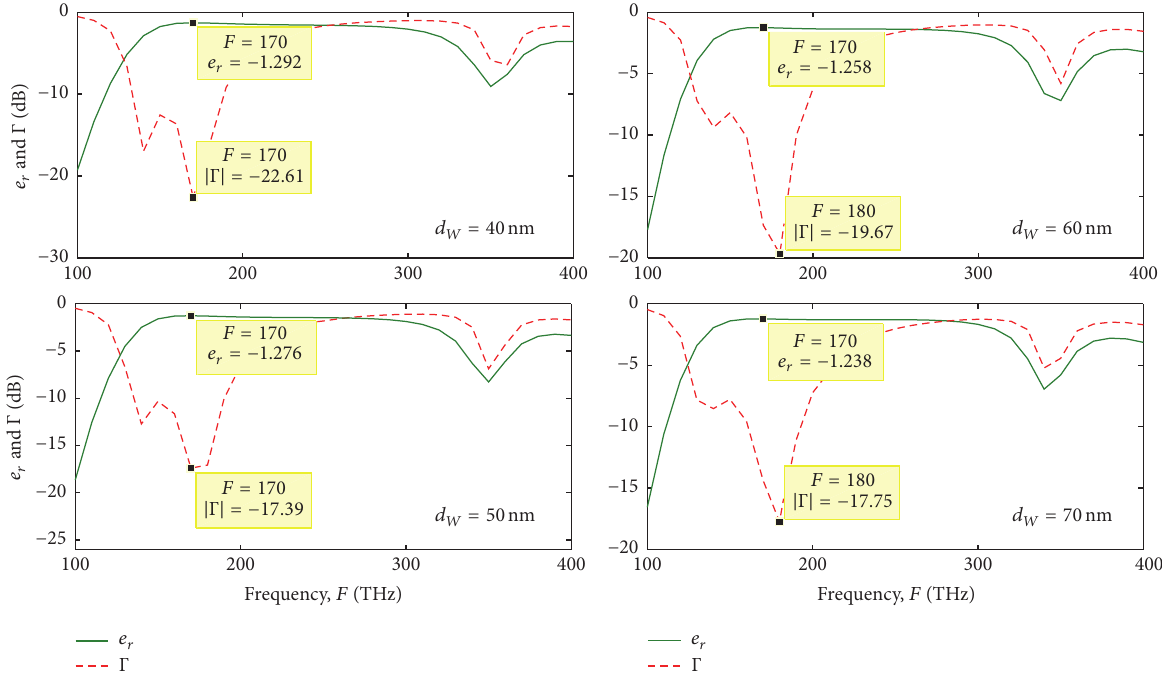
Figure 14: Radiation efficiency ( 𝑒 𝑟 ) and reflection coefficient ( Γ ) of the composed nanoantenna as a function of the frequency calculated through Comsol with 𝑑 𝑊 = 40, 50, 60, and 70 nm and 𝑑 𝐻 = 20 nm.